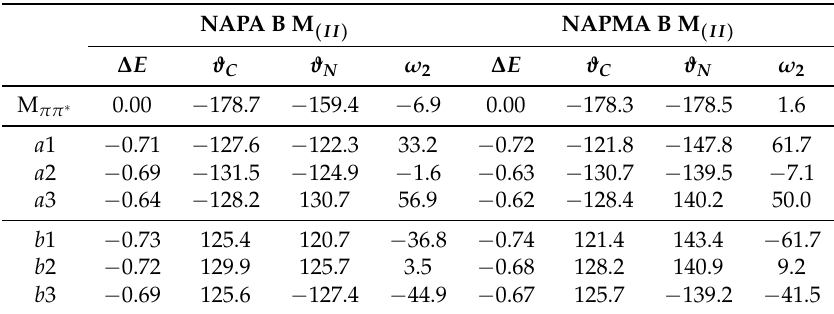
Table 3. Relative energies ( ∆ E ) of M ππ ∗ and M ( II ) minima in NAPA B and NAPMA B. The three torsional angles, ϑ C , ϑ N and ω 2 , shown in Figure 3 describe the deplanarization of the second amide group. Energies are in eV, angles in degrees.